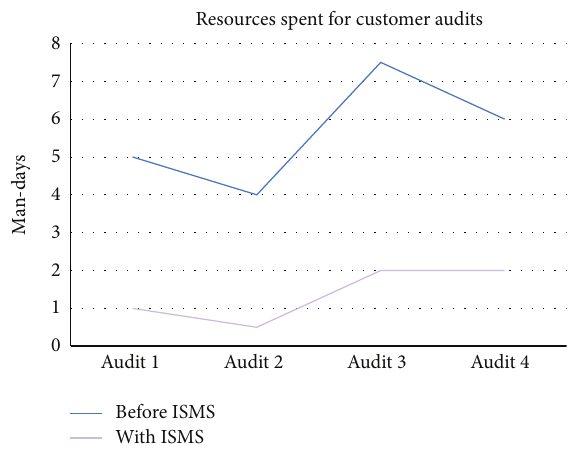
Figure 3: Resources needed to conduct customer audits.